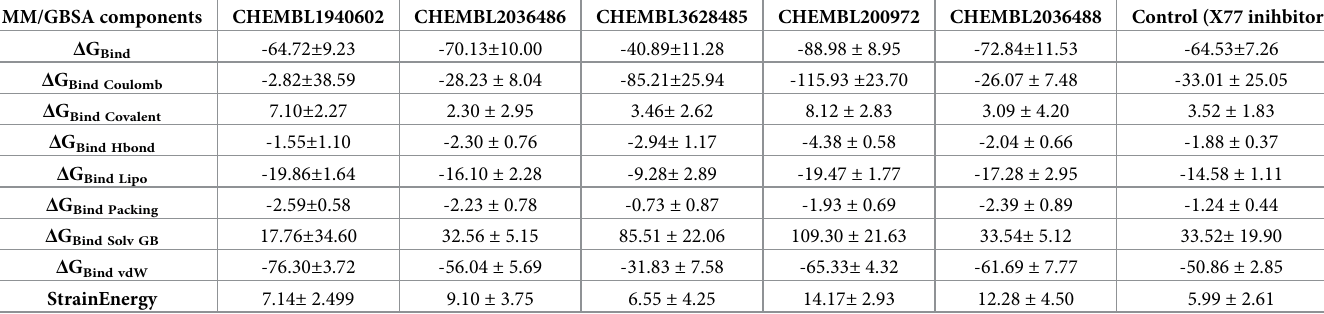
Table 2. MM/GBSA binding energy components for selected and control